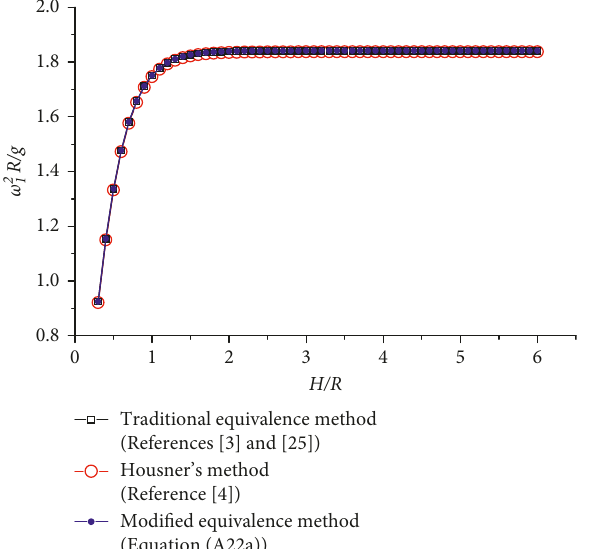
Figure 8: The first nondimensional sloshing frequency ω 2 the fluid depth ratio H / R (cylindrical tank).